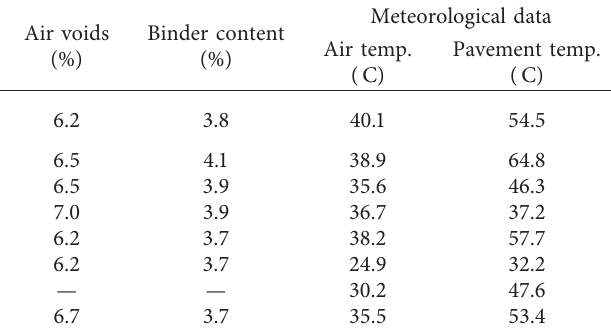
Table 1: As-built pavement and meteorological data during OBSI testing.